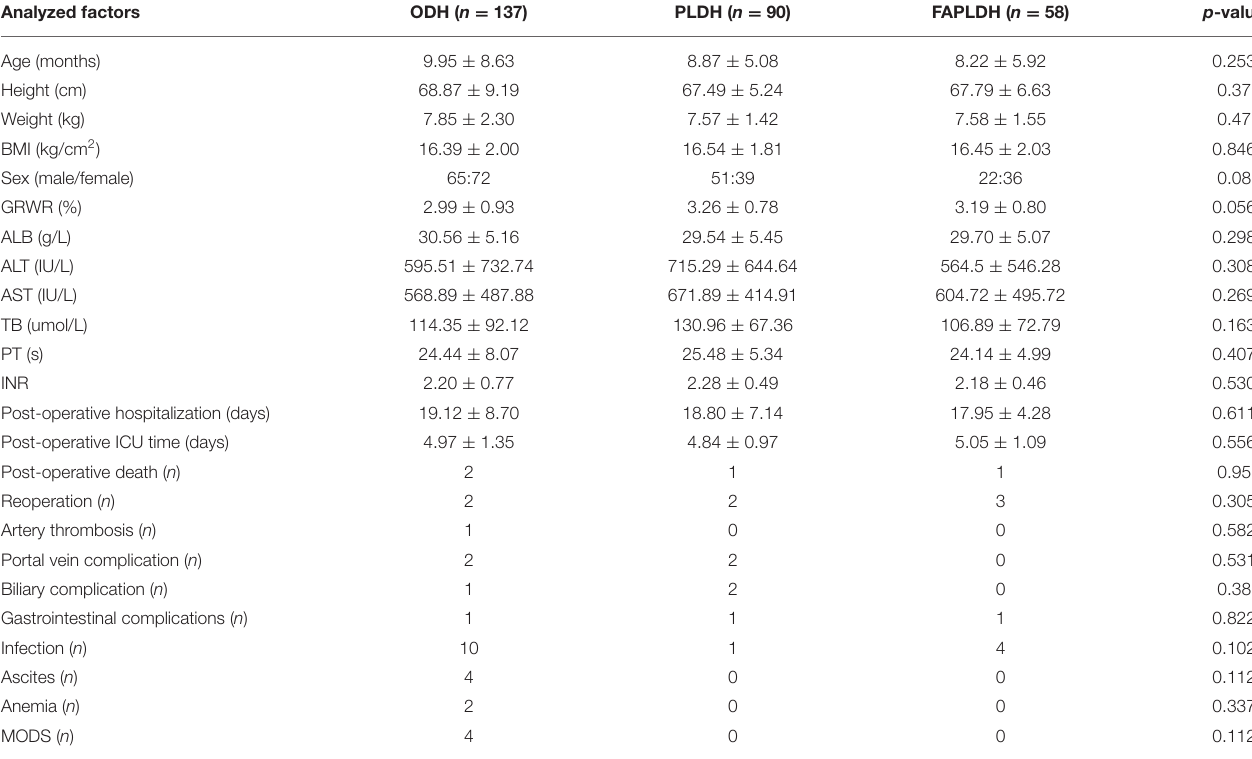
TABLE 2 | Recipients’ baseline characteristics and